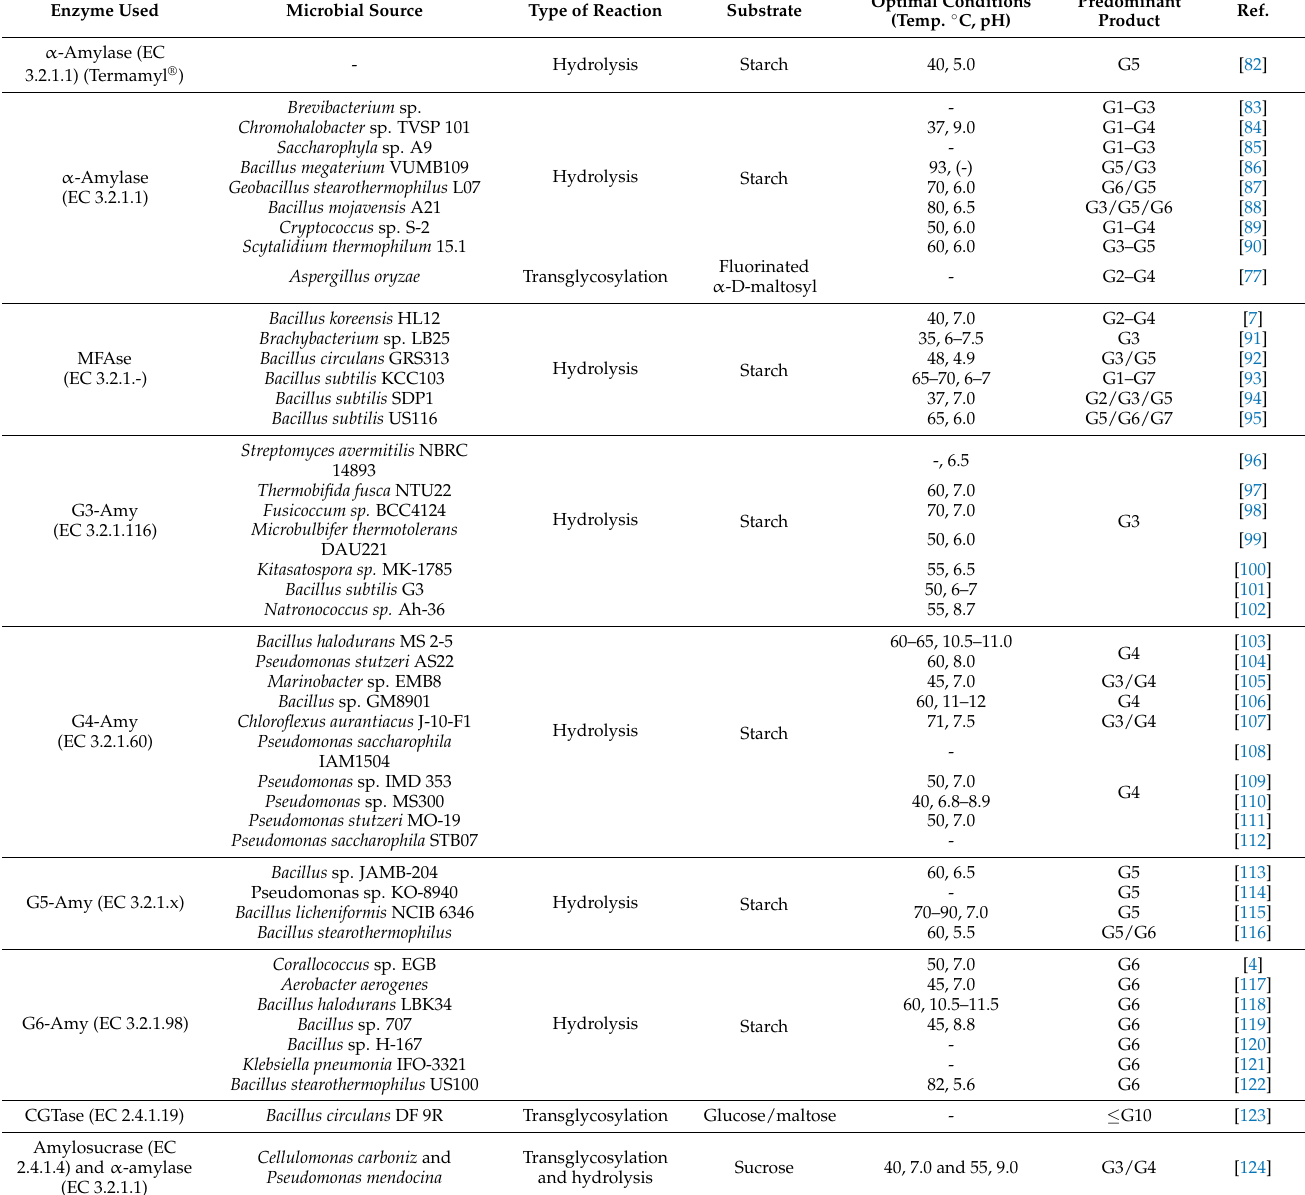
Table 3. Enzymes for the production of